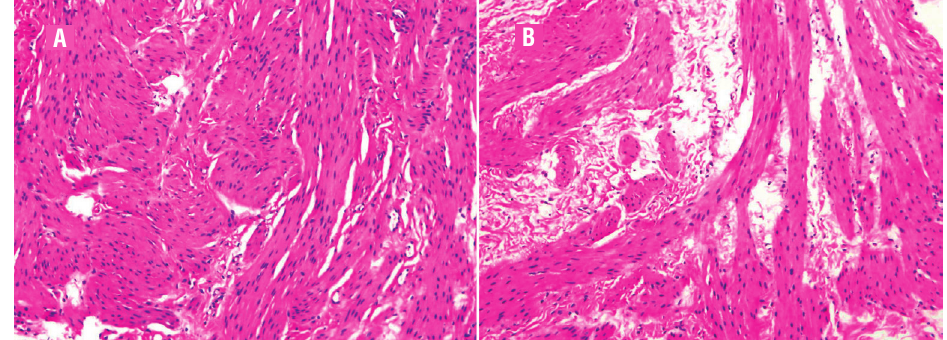
Figure 6 - The frozen section of collagen fiber (h&E staining, x200). a) control group; b) detrusor